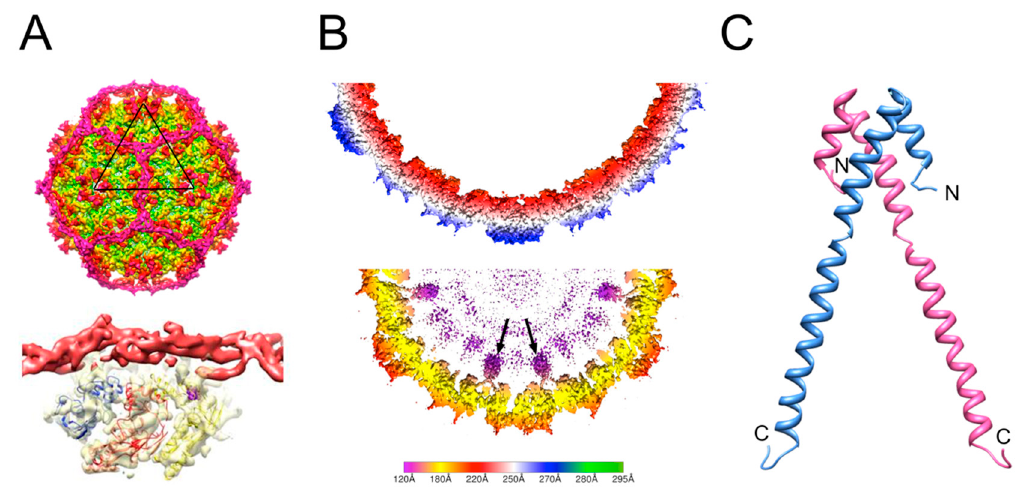
Figure 3. Size redirection by P4 and type 1 SaPIs. ( A ) Isosurface representation of the P4 procapsid reconstruction (top) showing the dodecahedral cage made by Sid (magenta). The bottom image shows the Sid density (red) as it interacts with the CP hexamer underneath (yellow surface; three copies of CP are modeled into the density). ( B ) Slice through the three-dimensional reconstructions of 80 α (top) and SaPI1 (bottom) procapsids, scaled radially according to the color bar (radius in Å). The internal protrusions corresponding to CpmB (purple) are indicated by arrows. ( C ) Ribbon representation of the SaPI1 CpmB dimer, made as a composite between the CpmB NMR structure (PDB ID: 2L8T) and the SaPI1 cryo-EM structure (PDB ID: 6B23). N- and C-termini are labeled.